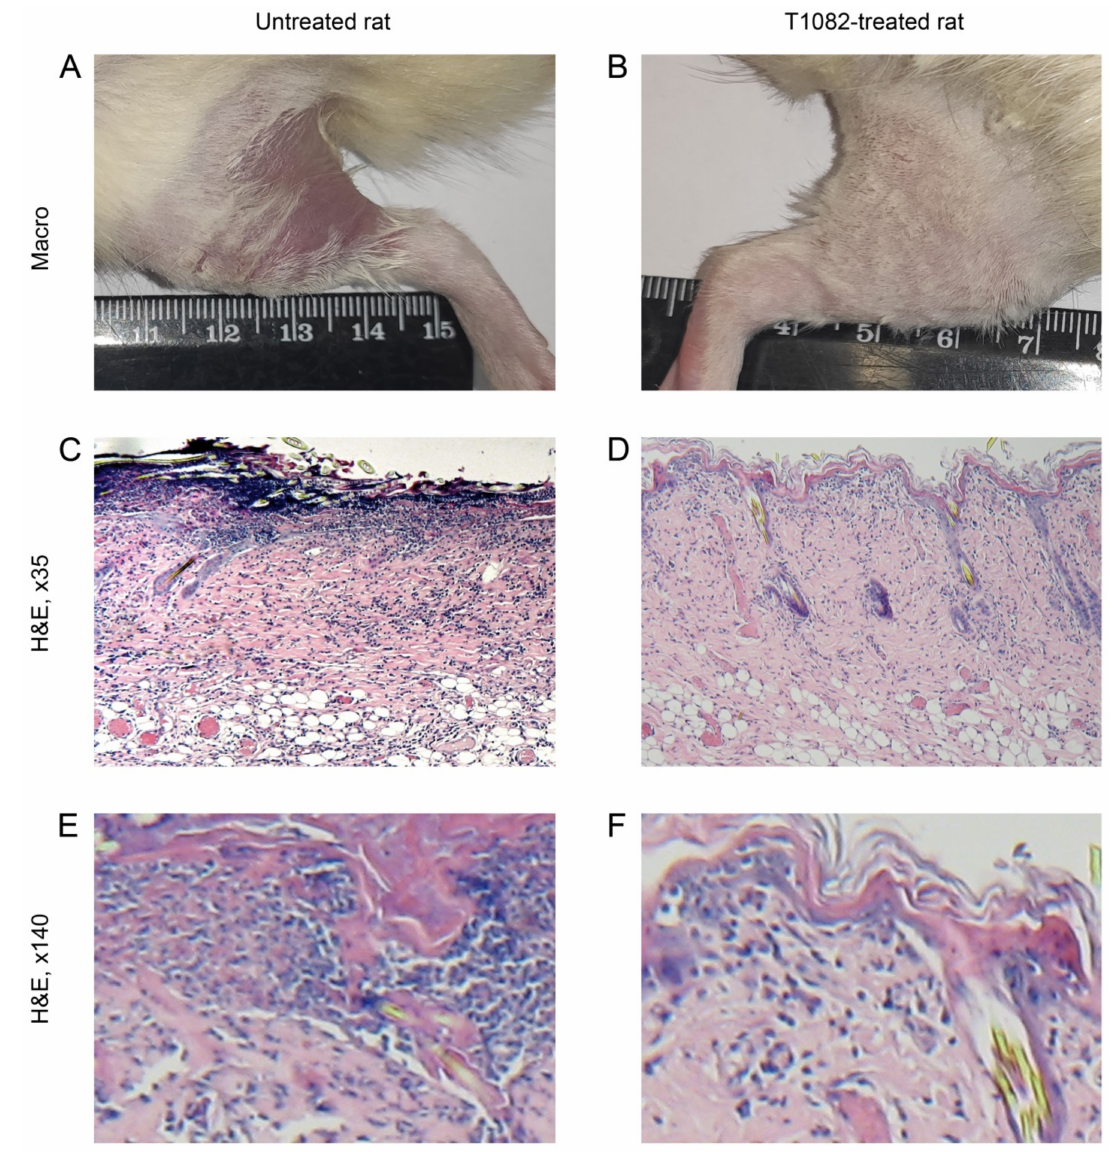
Figure 5. The effect of compound T1082, at a dose of 160 mg/kg i.g. (1/14 LD 10 ), by single ad- ministration, on the morphology of rat hip tissues on day 11 after β -ray LI at a dose of 40 Gy. ( A , B ) Macroscopic pictures. ( A ) Untreated rat. The RSR corresponds to 3 degrees according to the RTOG scale: severe hyperemia and edema, extensive epilation, and confluent exudative epidermitis, spreading to the inguinal area. ( B ) T1082-treated rat. The RSR corresponds to 1 degree according to the RTOG scale: weak epilation, moderate erythema, single petechiae (less than 1 mm), and intensive dry desquamation. ( C , D ) General histological picture of thigh tissues (H&E; × 35). ( C ) Untreated rat. The epidermis is destroyed and, in some places, thin-walled scrabs form from necrotic masses infiltrated by neutrophils; the dermis is edematous, collagen fibers are swollen, and the hair fol- licles are destructured, but the hypodermis is little changed and the subcutaneous vessels have a preserved structure. ( D ) T1082-treated rat. The epidermis is preserved, but unevenly thickened due to the proliferation of basal and spiny cells; the stratum corneum is stratified in places and, in the moderately edematous dermis, intact appendages with a thickened outer epithelium are visible, while subcutaneous adipose tissue is not changed. ( E , F ) Fragments of C-D, respectively (H&E, × 140). ( E ) Untreated rat. Intensive leukocyte infiltration extending to the external root sheath, replacement of the hair follicle. ( F ) T1082-treated rat. Moderate infiltration of fibroblasts and lymphocytes in the upper